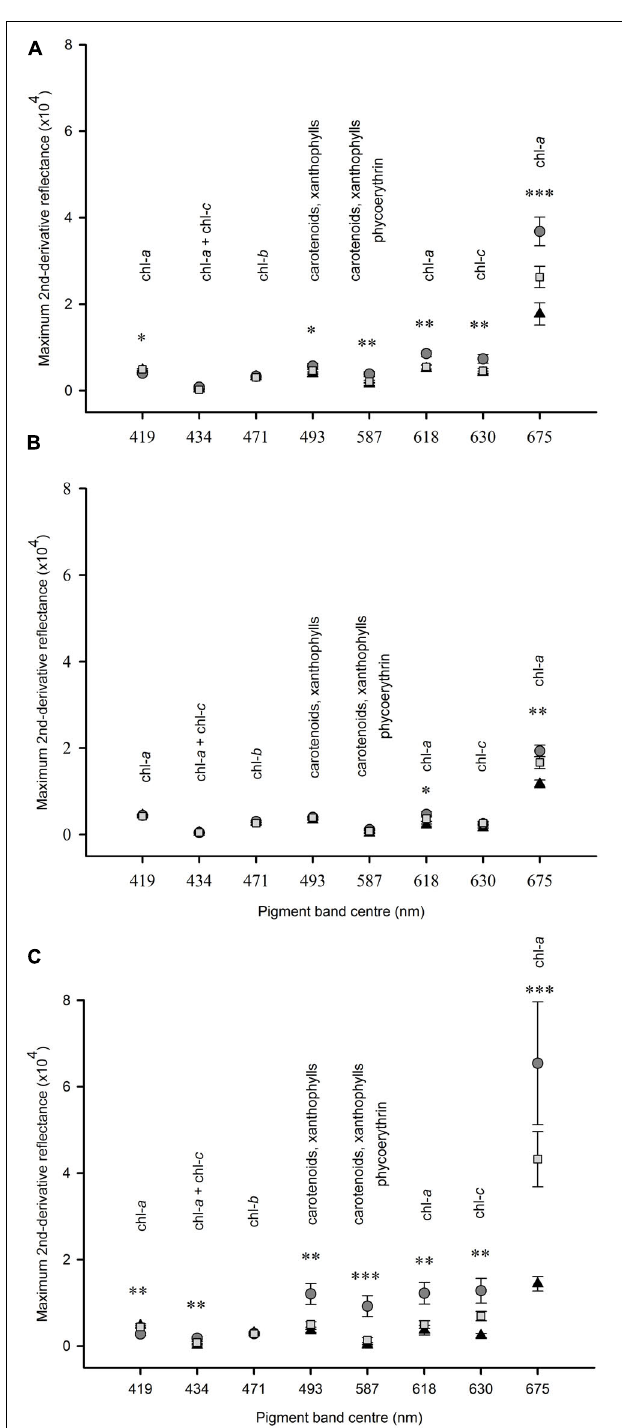
FIGURE 5 | Mean (SE) amount of absorption by pigments at different wavelengths between 400 and 800 nm under heavy shading ( (cid:78) ); light shading ( • ); unshaded control plots ( (cid:4) ). Panel (A) after 2 weeks at Tambourine Bay, n = 2; (B) after 2 weeks at Gore Creek, n = 4; (C) after 3 months at Tambourine Bay, n = 4. Data were analyzed using ANOVA on untransformed data, asterisks indicate significance, ∗ p < 0.05, ∗∗ p < 0.01, ∗∗∗ p <